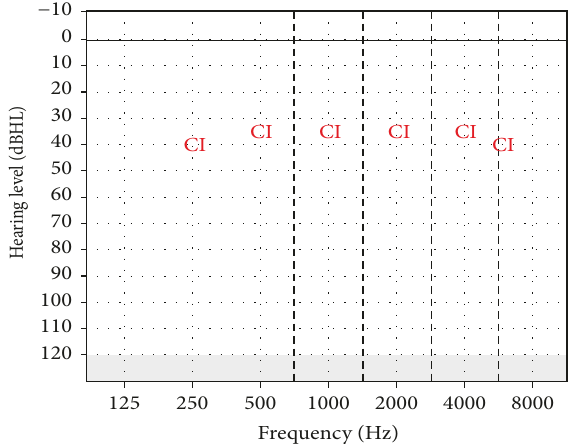
Figure 2: Hearing thresholds with CI in the 1st year for Case 1